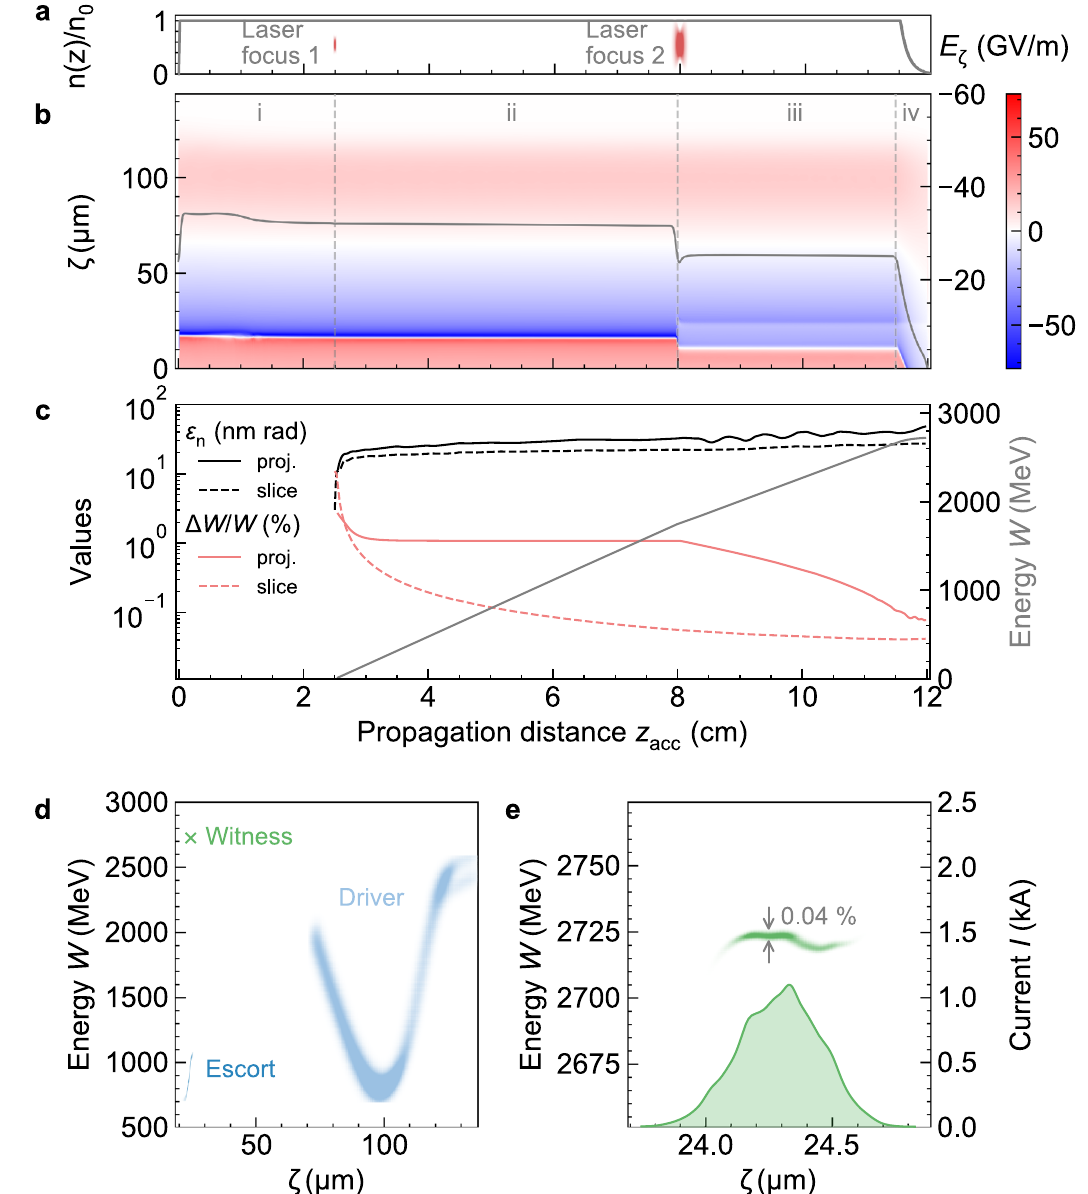
Fig. 2 | Particle-in-cell simulation of PWFA stage. a The longitudinal plasma density pro fi le n ( z )/ n 0 is quickly ramped up and remains constant until the extractiondownramp.Alsoshownisthelocationoftheplasmaphotocathodelaser foci that generate witness ( 1 ) and escort ( 2 ) electrons. b Colour-coded on-axis longitudinalwake fi eldevolution E ζ vs.co-movingcoordinate ζ withtheelectric fi eld evolution at witness bunch position (solid grey line, right y -axis). The dashed lines